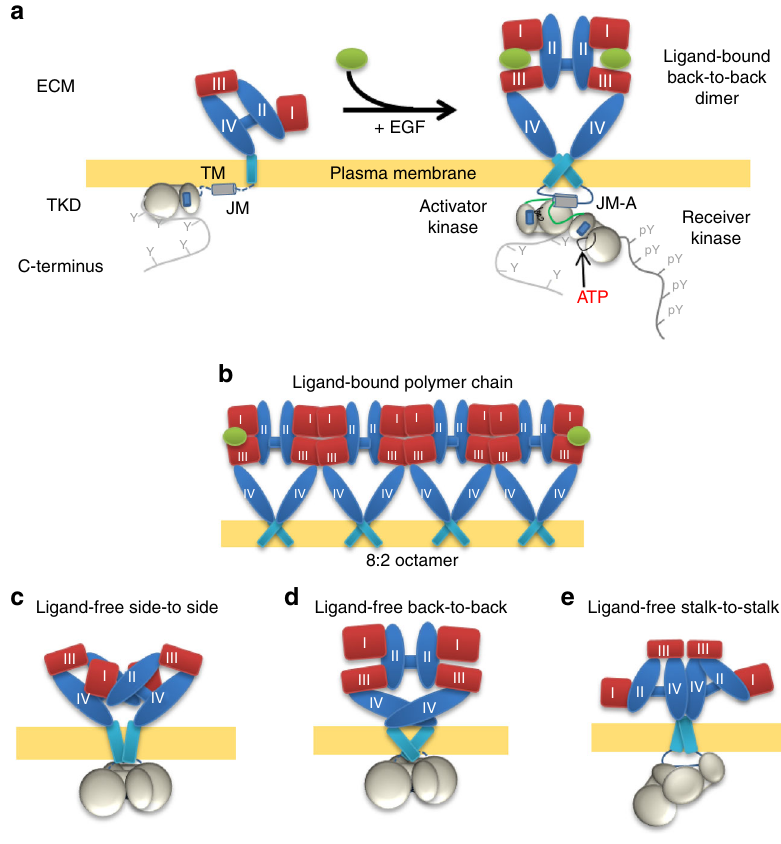
Fig. 1 Models of ligand-free and ligand-bound EGFR complexes. a Top left: Cartoon of an EGFR monomer 5 . Top right: A ligand-bound back-to-back extracellular dimer 8,9 . This is linked to the catalytically active asymmetric TKD (aTKD) dimer 10 by an N-terminal crossing transmembrane (TM) dimer 40 and an antiparallel juxtamembrane-A (JM-A) helical dimer 22 . b Cartoon of the extracellular portion and TM domains of ligand-bound EGFR polymers formed by alternating back-to-back and face-to-face interfaces 12 . Two EGF molecules are bound at the end-receptors capping the polymer chain with a 2N:2 receptor/ligand stoichiometry. An 8:2 octamer is shown (intracellular regions not depicted). c Cartoon of a speculative ligand-free side-to-side dimer that would putatively combine the double autoinhibition of a tethered extracellular domain and a symmetric tyrosine kinase domain (sTKD) dimer 5,20,22 . d Cartoon of a ligand-free extended back-to-back dimer coupled via a TM domain C-crossing dimer to an sTKD dimer (modi fi ed from Arkhipov et al. 23 ). e Cartoon of a stalk-to-stalk tethered dimer coupled via an N-crossing TM domain dimer to the aTKD dimer induced by TKI binding in the C-terminal domain truncated Δ 998-EGFR (modi fi ed from Lu et al. 26 ). For all panels ECM domains I and III are in red, II and IV in blue, EGF ligand is in green, plasma membrane in yellow, TM in teal, JM in dark grey, TKD in light